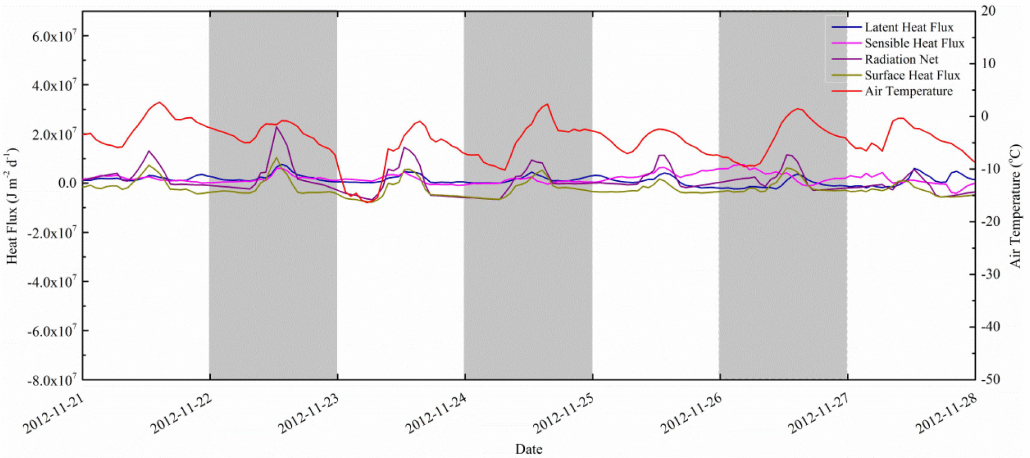
Figure 7. Diurnal changes in energy partitioning. The blue, magenta, purple, dark yellow, and red lines are for latent heat, sensible heat, net radiation, surface heat flux, and air temperature,